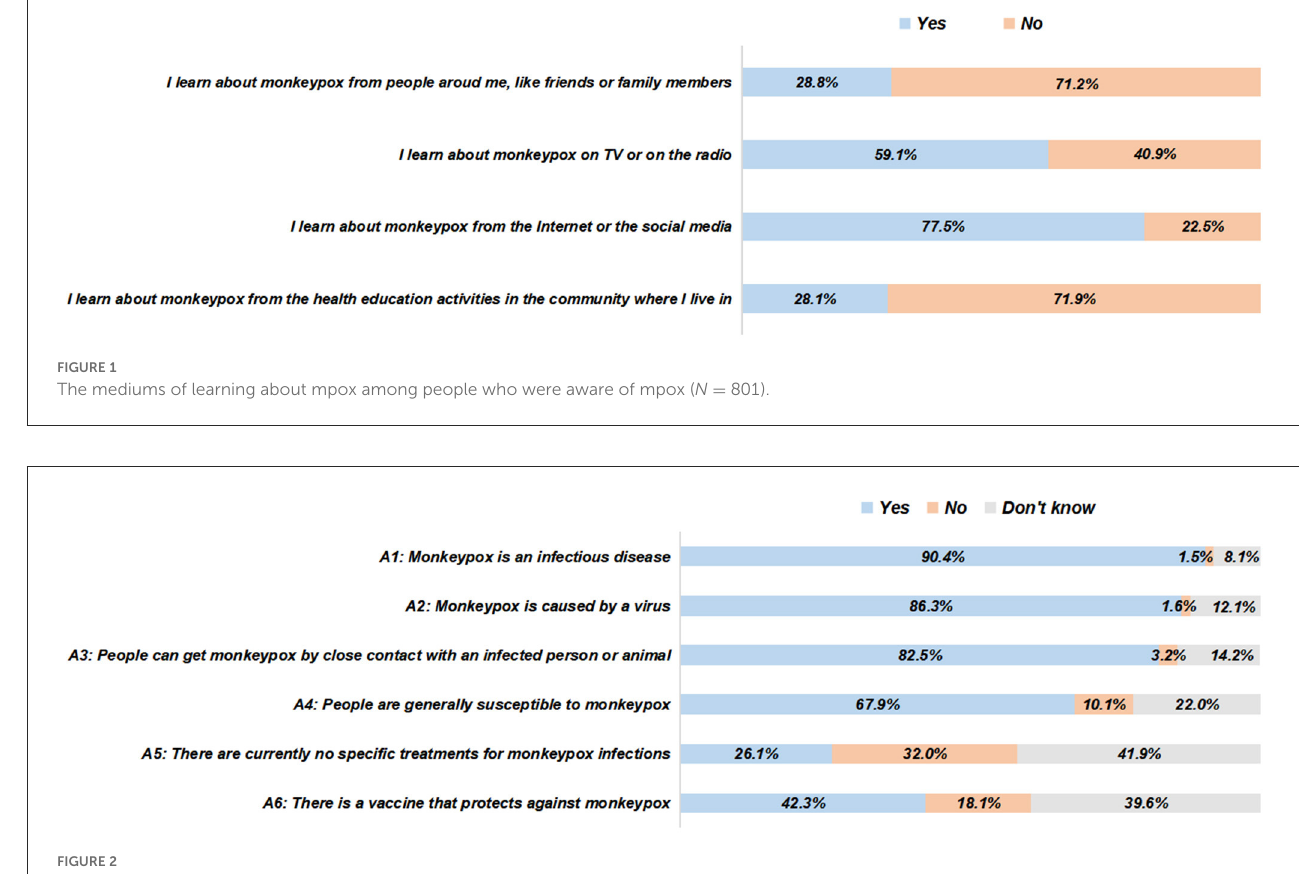
mpox were also detected (Table 4). Factors that were positively associated with a high level of worry included being female (OR: